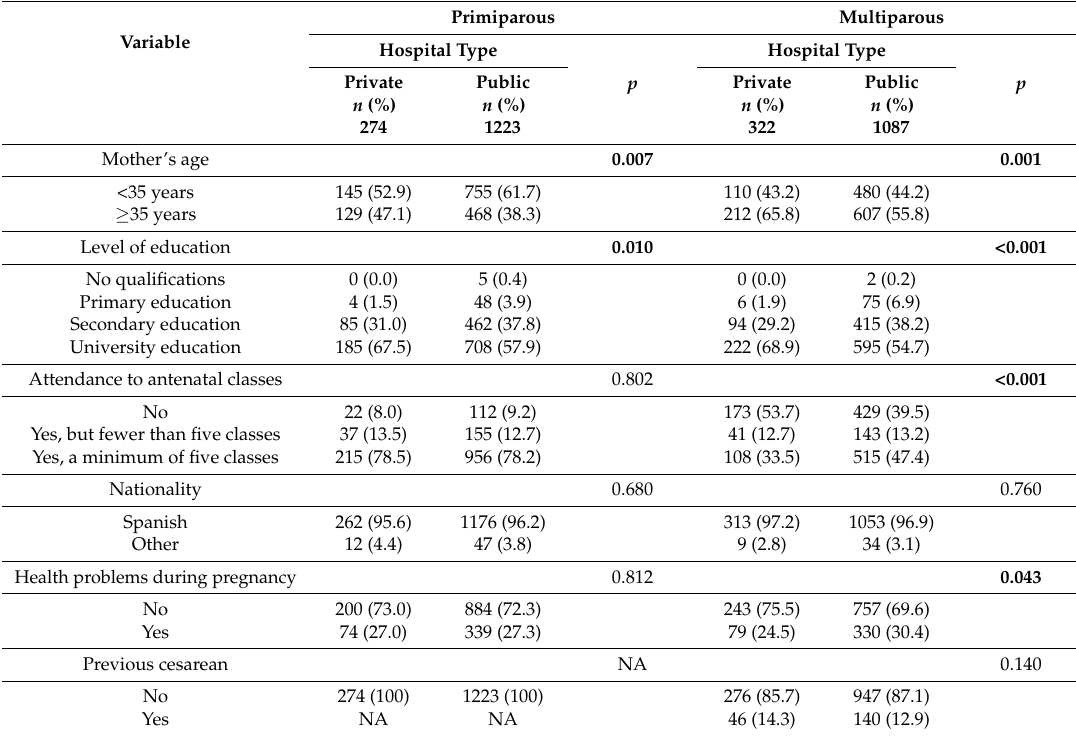
Table 1. Study population’s characteristics.